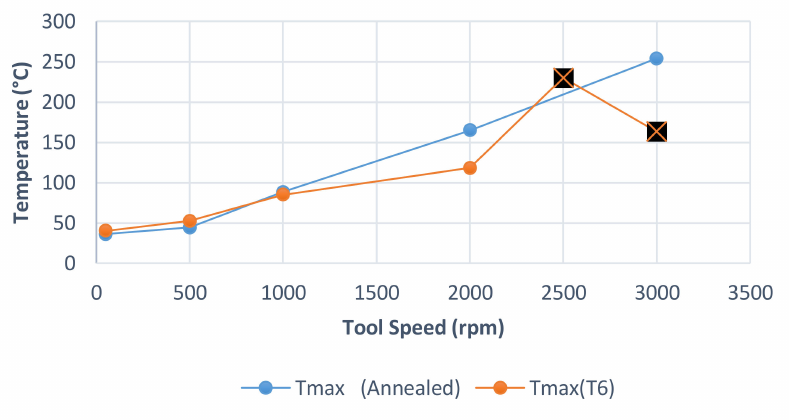
Figure 10. Comparison for maximum temperature rises at di ff erent tool speed for annealed and T6 sheets (black x dots show failure of sheet before 25 mm at the respective